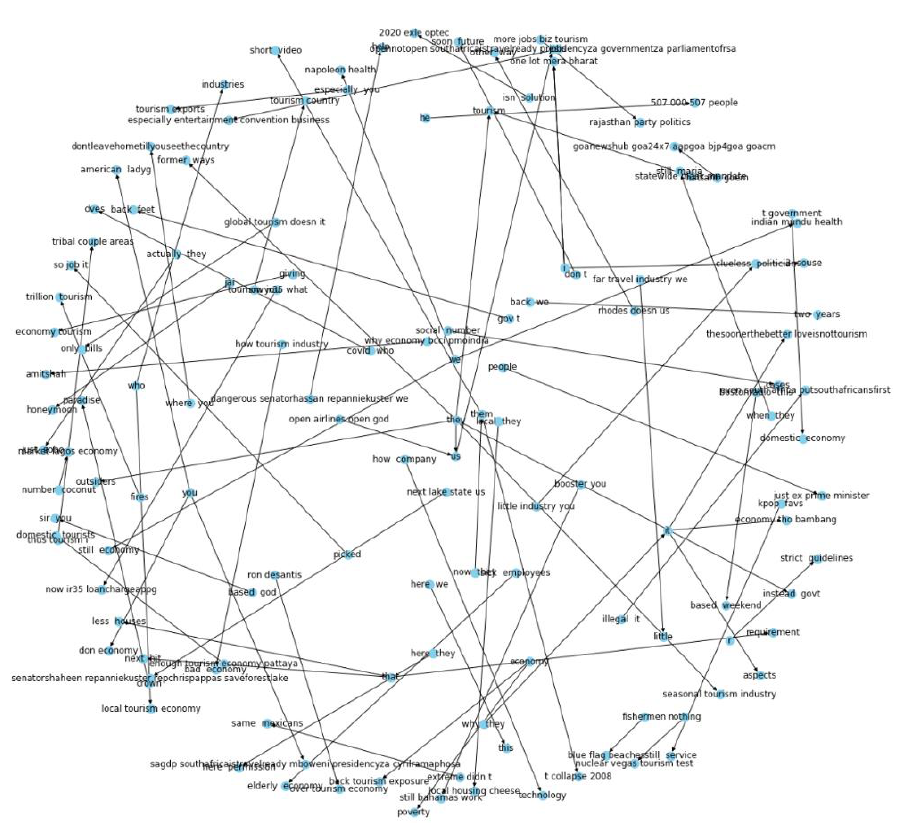
Figure 22. Knowledge Graph for Cluster 3.